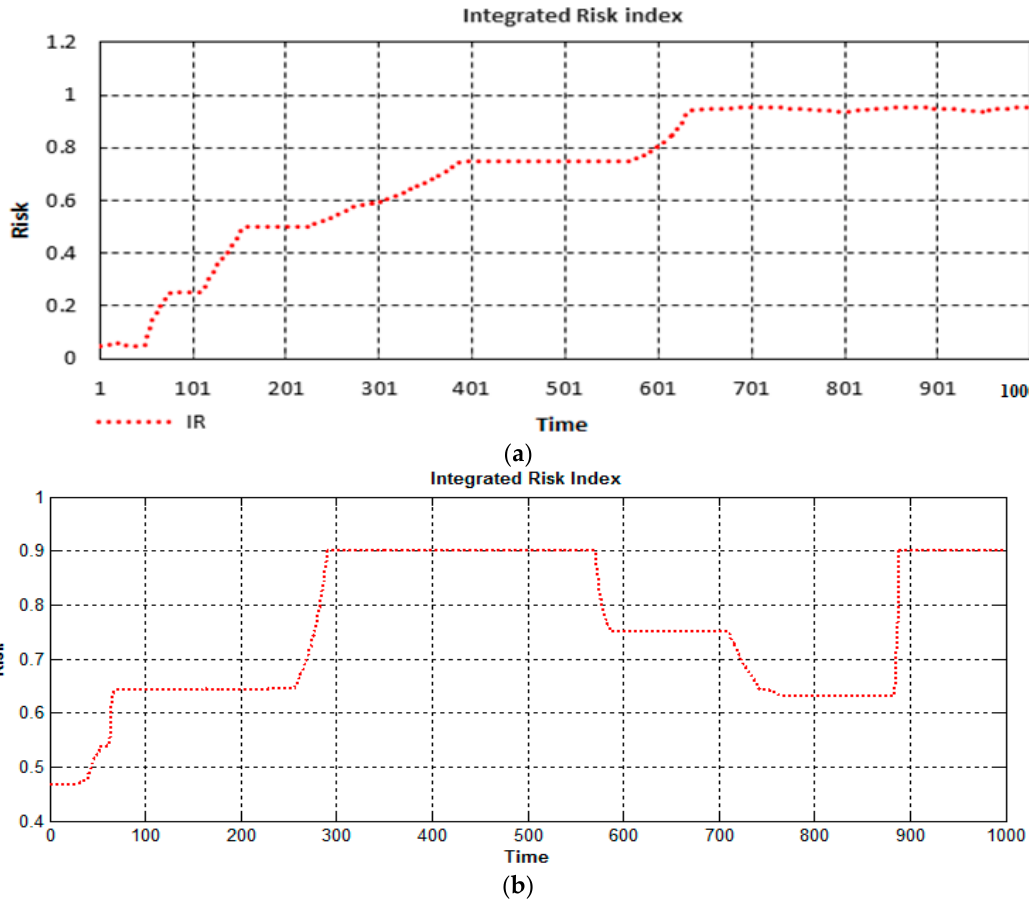
Figure 14. Output of fuzzy logic for ( a ) maximum rule-based; and ( b ) average rule-based rules in integrated layer.